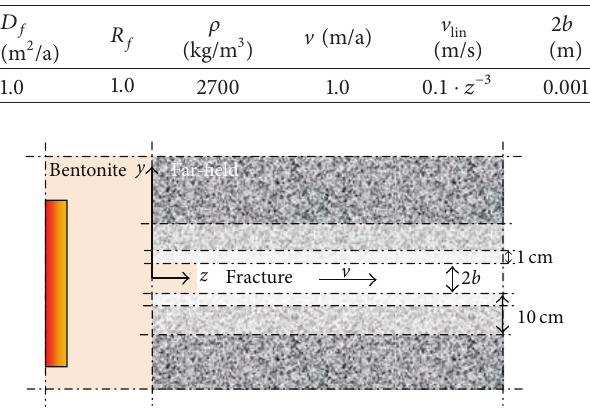
Table 3: Constant parameters for all nuclides in model: longitudinal dispersion coefficient ( 𝐷 𝑓 ), retardation coefficient ( 𝑅 𝑓 ), density of the rock ( 𝜌 ), groundwater velocity ( V ), lineament velocity ( V lin ), and fracture aperture ( 2𝑏 ).